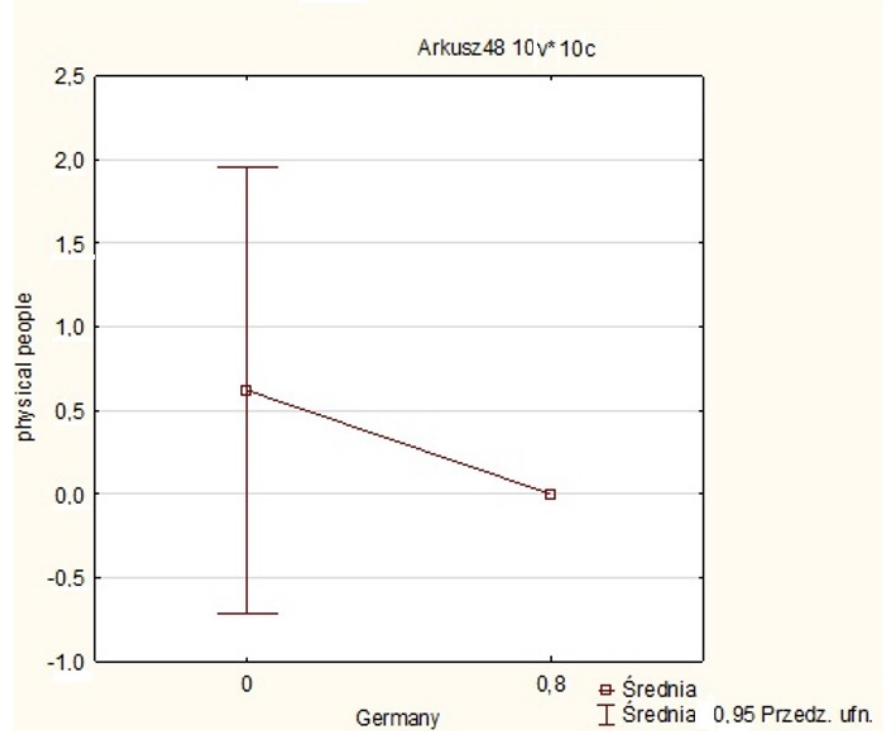
Figure 26. German in the opinion of entrepreneurs (hydrogen